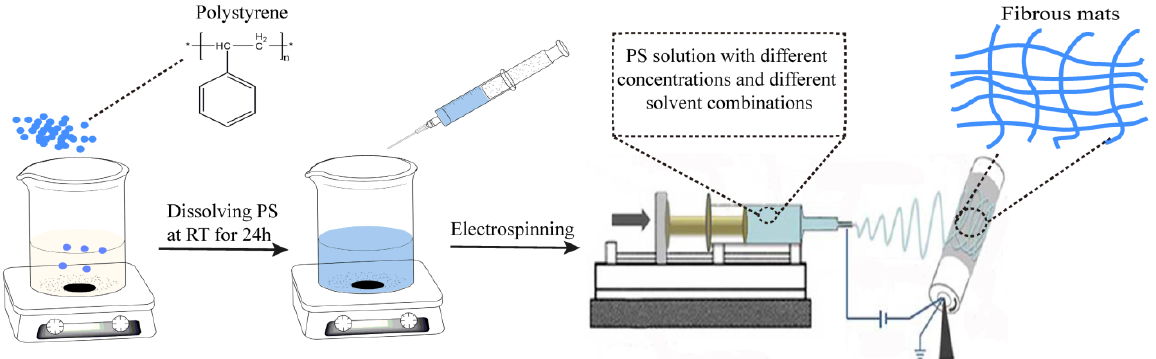
Figure 1. Schematic illustration of electrospinning process of polystyrene (PS) solutions and manufactured PS nanofibrous